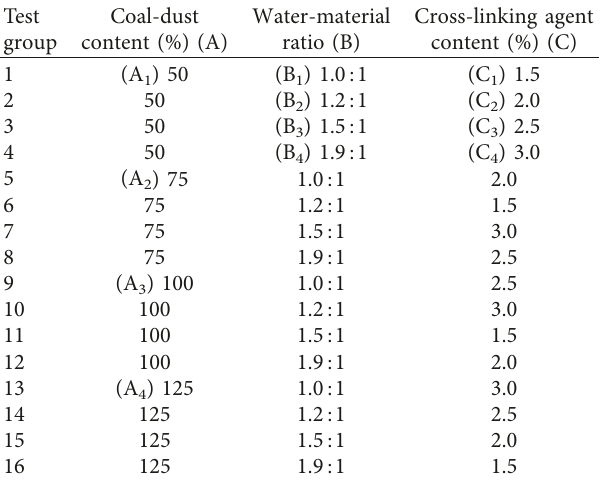
Table 2: Scheme of the orthogonal